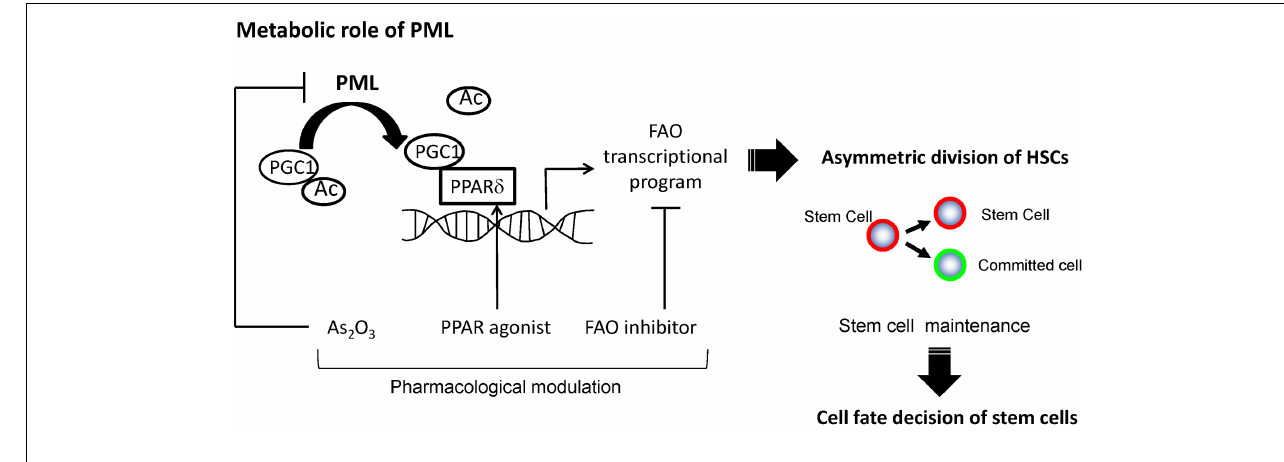
fatty acid oxidation (FAO).These metabolic changes promote HSCs toward the fate of asymmetric cell division, leading to their